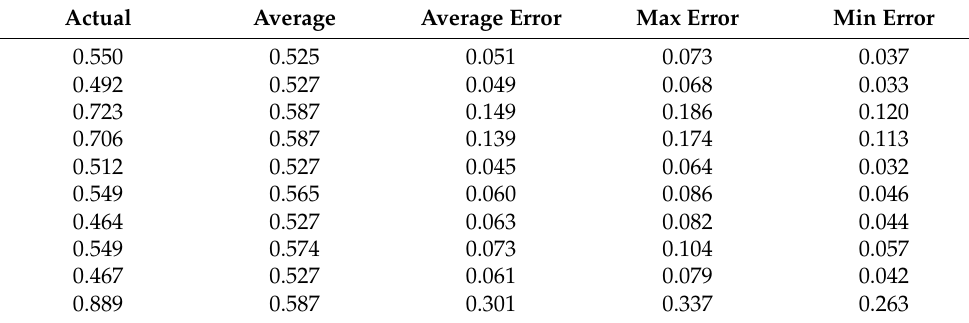
Table A64. Set 1, trials 41–50 data (actual PR value).